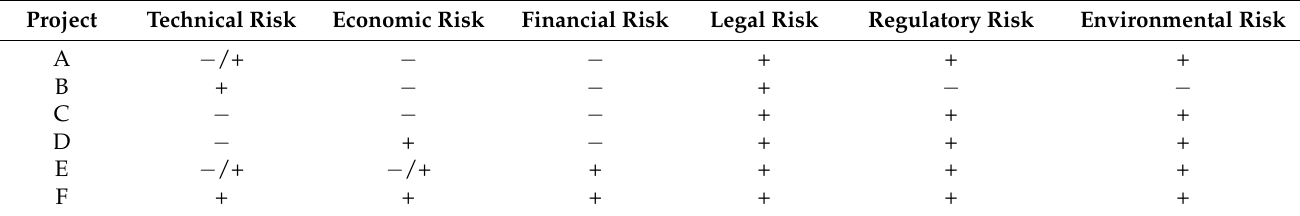
Table 10. Risks of CHP investment projects during the execution phase.